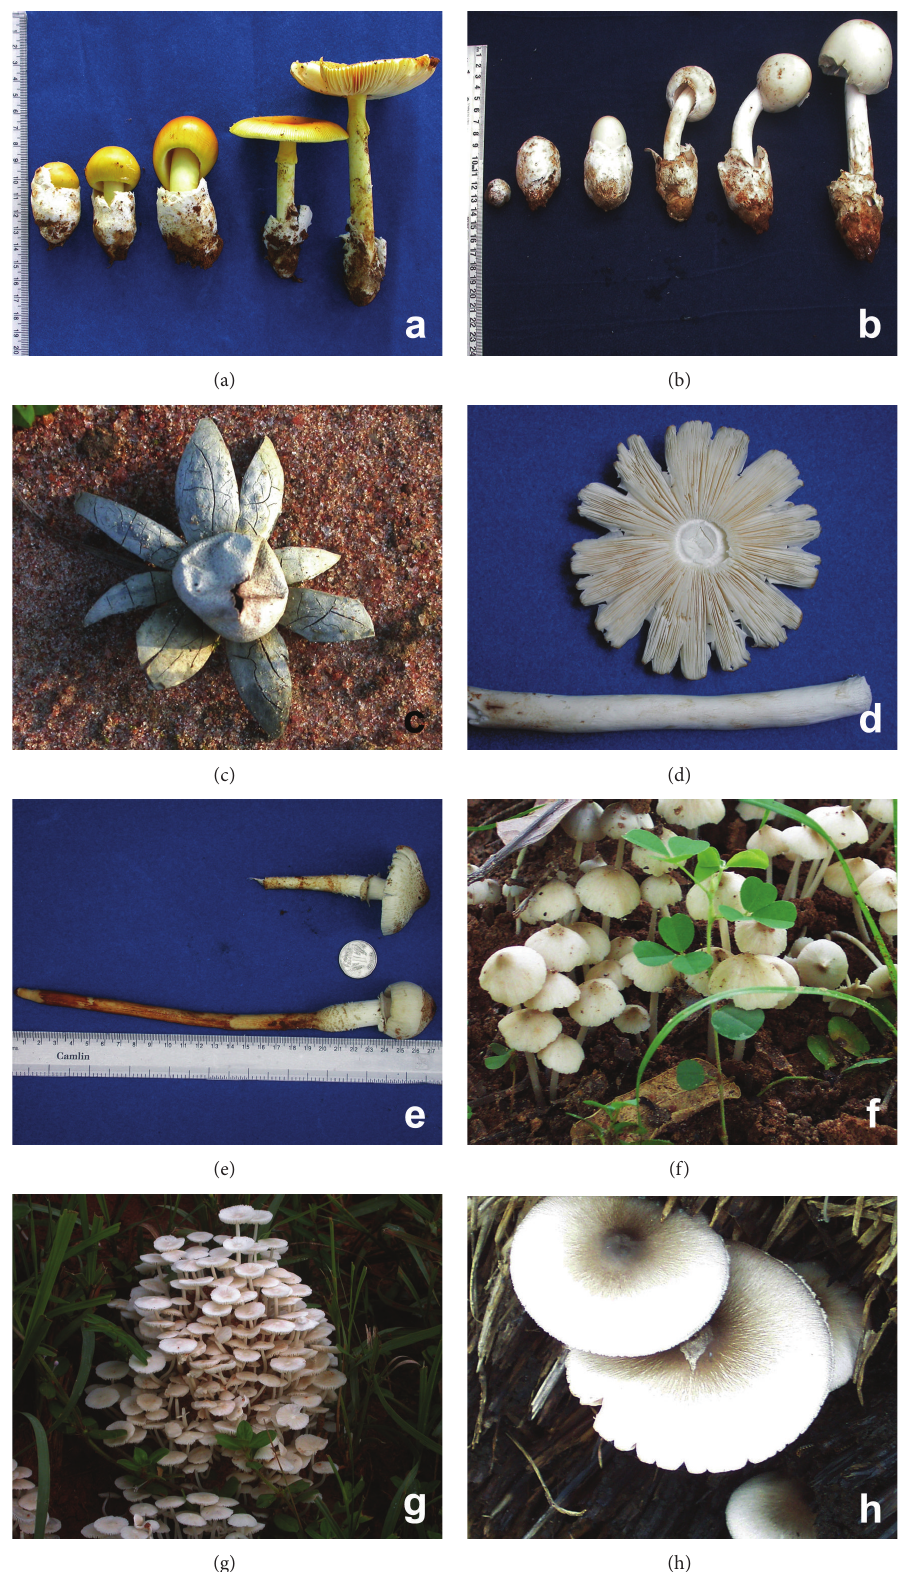
Figure 2: Fruit bodies of mushrooms. (a) Amanita hemibapha —CN 1. (b) Amanita sp.—CN 2. (c) Astraeus hygrometricus —CN 3. (d) Termitomyces sp.—CN 4. (e) Termitomyces sp.—CN 5. (f) T. microcarpus —CN 6. (g) Termitomyces sp.—CN 7. (h) Volvariella volvacea